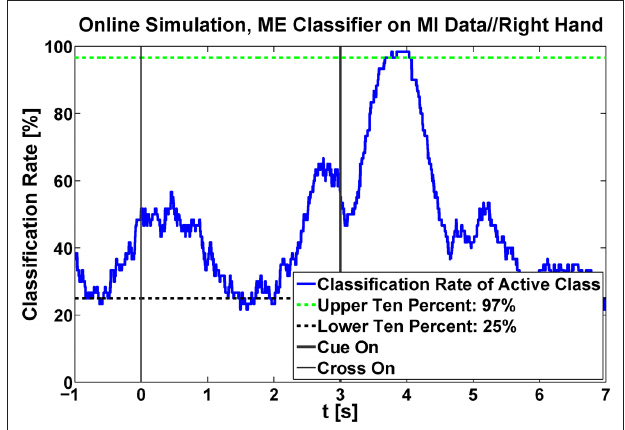
Figure 5 | Classification accuracy during the time of a whole trial for one exemplary subject. Here, a classifier, generated with data recorded during ME, was applied on MI data. The upper 10% during active MI and the lower 10% during rest were removed and the remaining highest/lowest values were kept as classification rates to avoid unrealistically high results due to peaks.